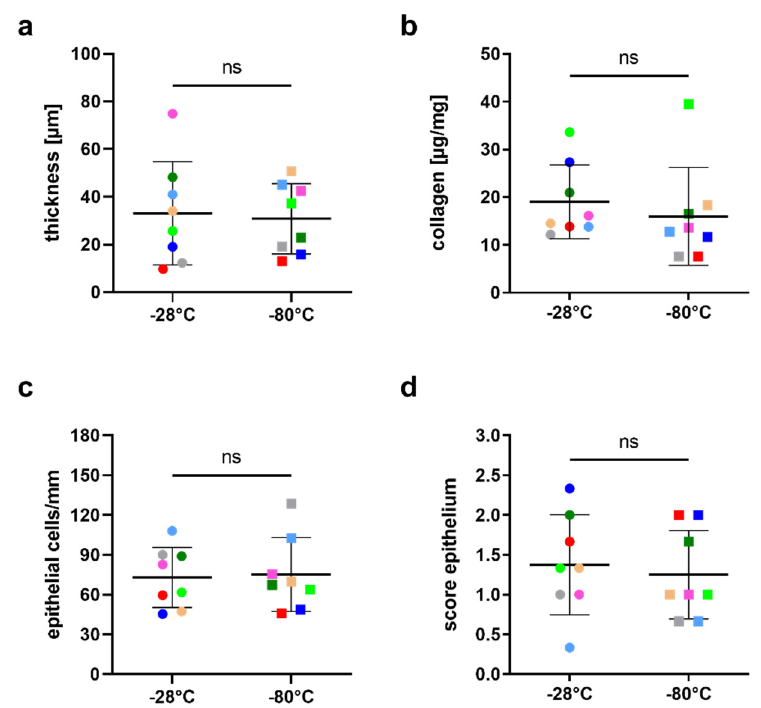
Figure 1. Thickness ( a ), collagen content ( b ), epithelial cell numbers ( c ) and epithelial cell morphology ( d ) after storage at -28 °C and -80 °C, respectively. Each data point represents the average of all three measurements on samples from one donor at the respective temperature. Horizontal bars show mean values for all donors at the respective temperature ± standard deviation. Pairs from the same donor are shown in matching colors. ns: Not statistically significant.